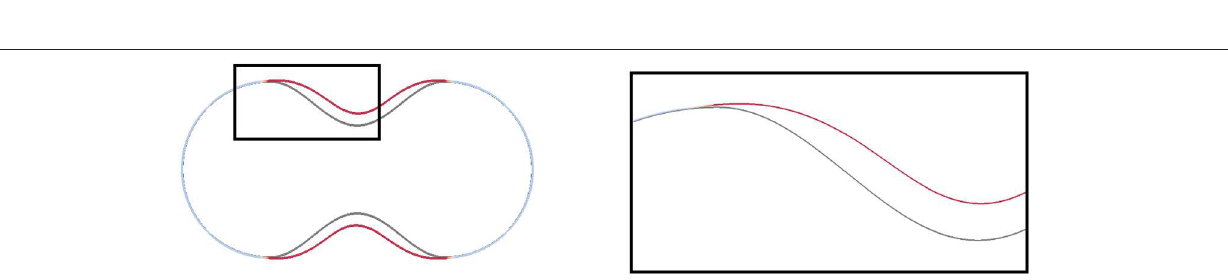
0.04 are highlighted in blue and values above the critical length of breaking u B = 0.85. For (D) , the pressure was increased by setting p 0 =